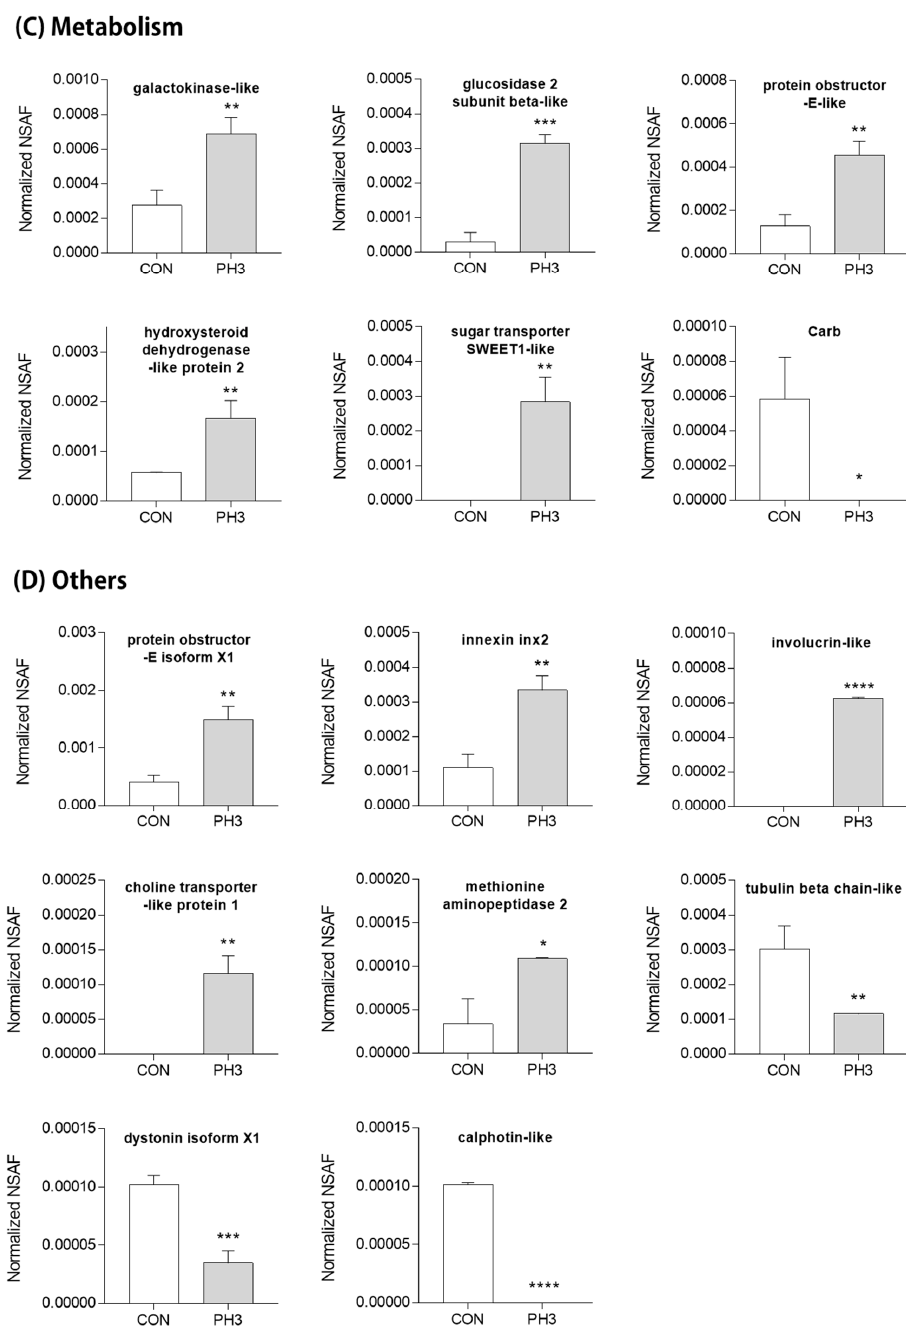
Figure 4. Proteins differentially expressed in adults of Myzus persicae after phosphine treatment at the concentration of 0.5 mg/L for 4 h. CON; control treatment group, PH3; phosphine treatment group. Statistically difference was analyzed using t -test ( p < 0.05). *, <0.05; **, 0.01; ***, 0.001; ****, 0.0001. ( A ), proteins involved in energy metabolism, especially electron transport chain; ( B ), proteins involved in defense; ( C ), proteins involved in metabolism; ( D ), other proteins.